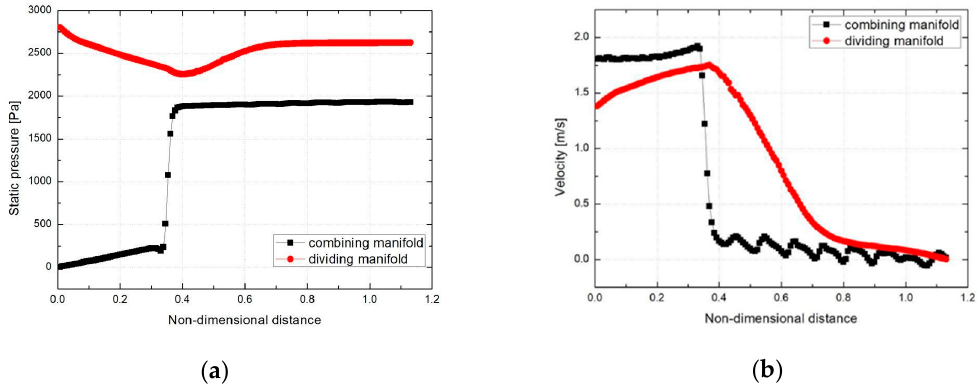
Figure 8. Pressure and velocity distributions along flow axis of U-type manifold: ( a ) Static pressure plot; ( b ) velocity plot.